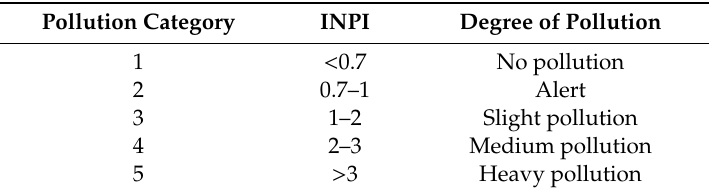
Table 1. Classification system for pollution level of the mangrove soils based on integrated Nemerow pollution index